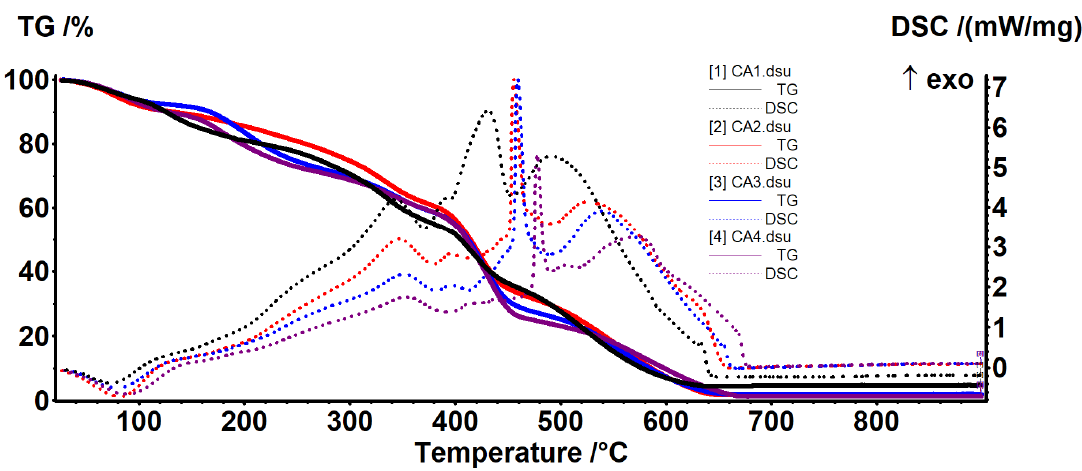
Figure 9. The TG-DSC curves for CA1–CA4. Table 4. Temperatures at which CA1–CA4 films lost 10%, 20%, 30%, 40%, or 50% of initial mass.